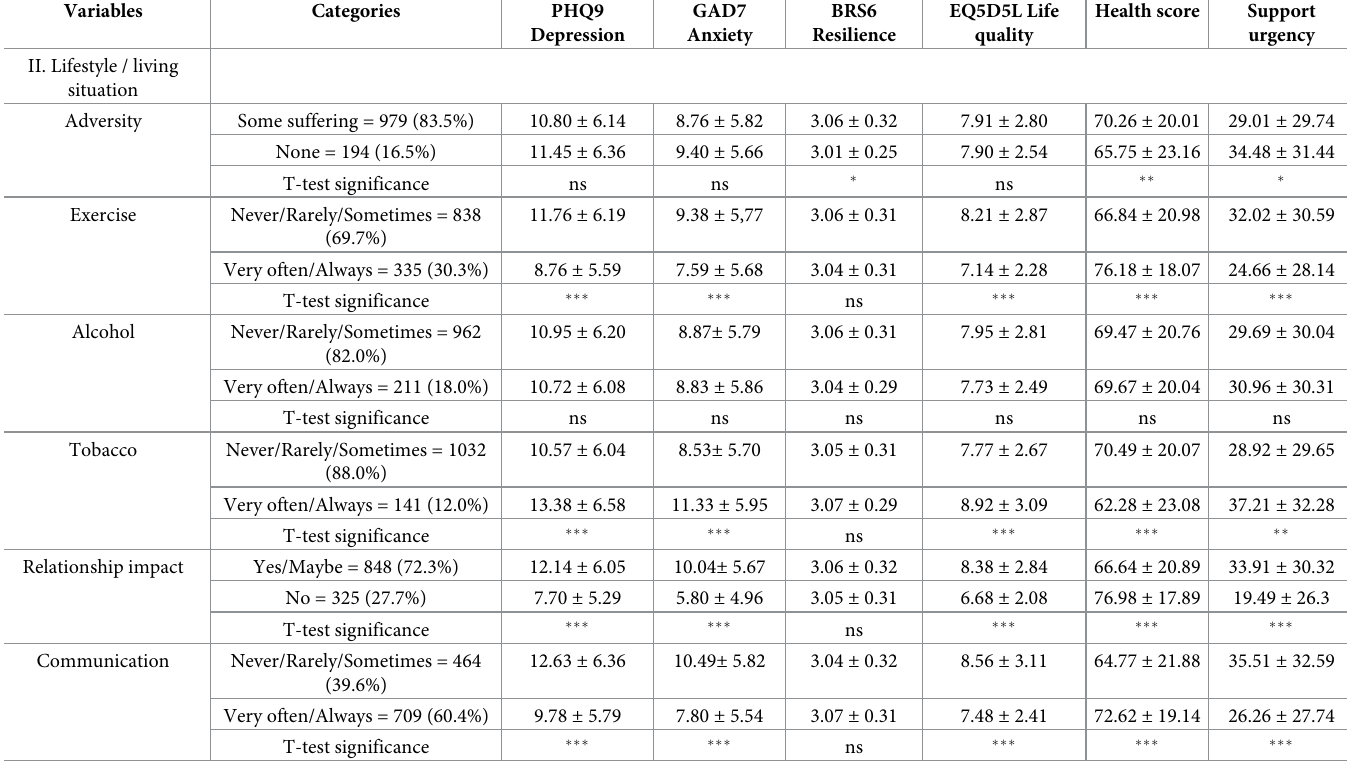
Table 7. Bivariate analysis on lifestyle / living